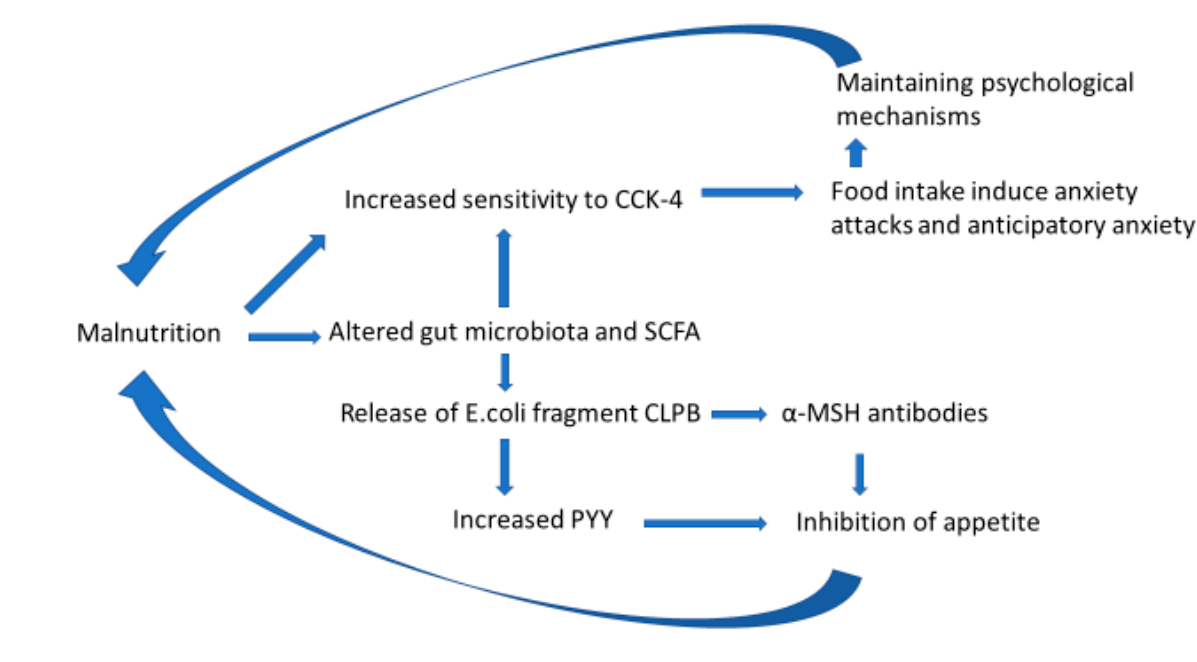
Figure 2. Model illustrating some potential malnutrition-induced neuroendocrine interactions in AN. Malnutrition is proposed to cause increased sensitivity to panicogenic CCK-4. This may be caused by malnutrition-induced alterations of gut bacteria with concomitant SCFA alteration and increased BBB permeability or other mechanisms. Food intake will induce CCK-4 release, and the brain’s CCK-2 receptor will induce anxiety attacks due to increased CCK-4 sensitivity. These attacks may induce anticipatory anxiety, and the development of maintaining psychological mechanisms with further weight loss. Malnutrition also seems to be associated with the release of the fragment CLPB from gut E. coli to blood. The CLPB fragment induces α -MSH antibodies and increased PYY that, in turn, inhibit food intake. AN: anorexia nervosa; CCK-4: fragment of cholecystokinin; E. coli : Escherichia coli ; CLPB: caseinolytic peptidase B; α -MSH: alpha-melanocyte-stimulating hormone; PYY: protein YY.